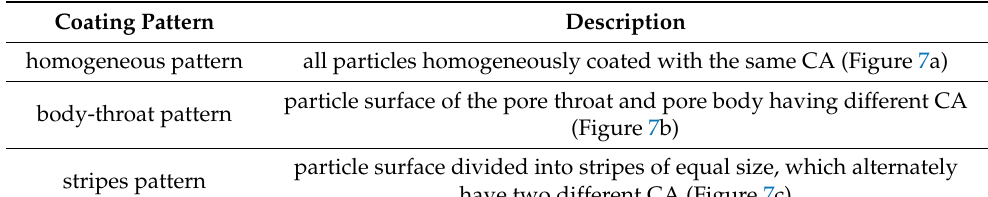
Table 1. Listing and description of all basic particle coating patterns used for the simplified porous medium.